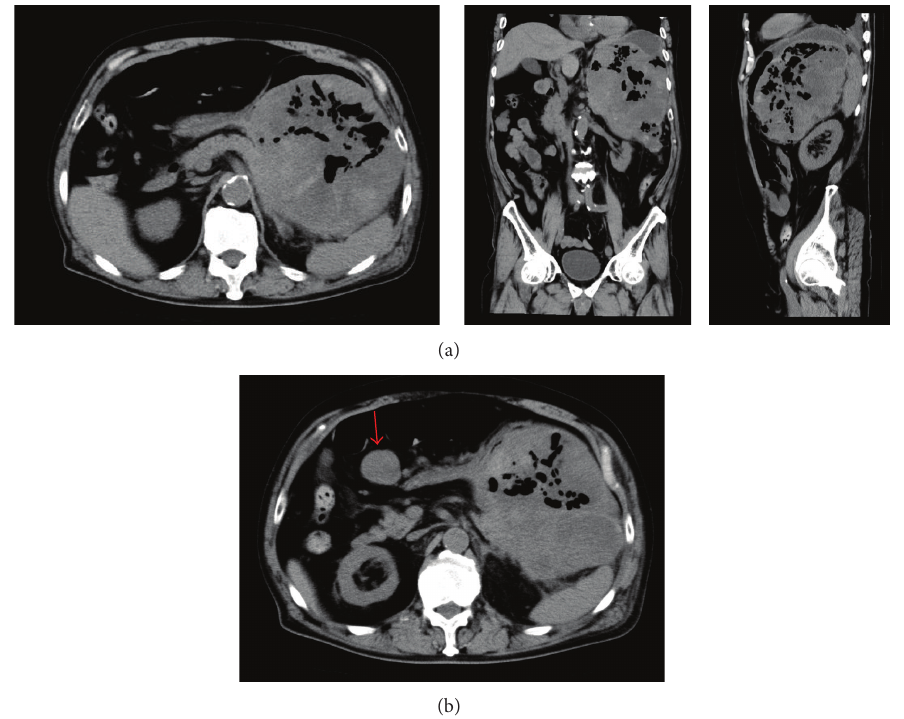
Figure 2: (a) Abdominal computed tomography (CT) scan showing a giant mass with central necrosis in the stomach. (b) Abdominal computed tomography scan showed a peritoneally disseminated lesion, measuring 30 × 30 mm in size